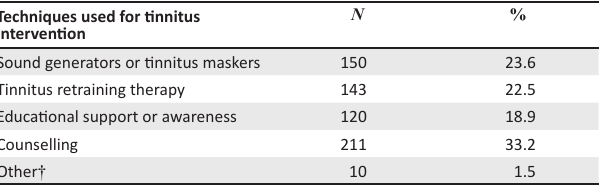
TABLE 9: Recommendations to improve the tinnitus management in adult patients ( n = 100).